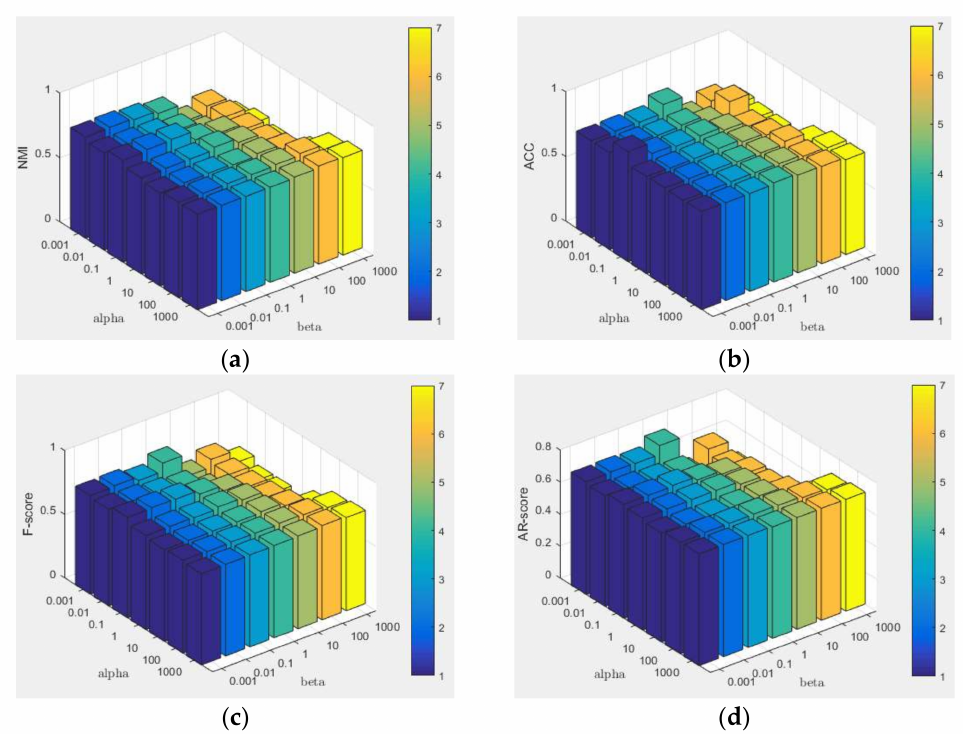
Figure A5. Sensitivity test on alpha and beta versus four metrics on Caltech101. ( a ) NMI, ( b ) ACC, ( c ) F-score, ( d )